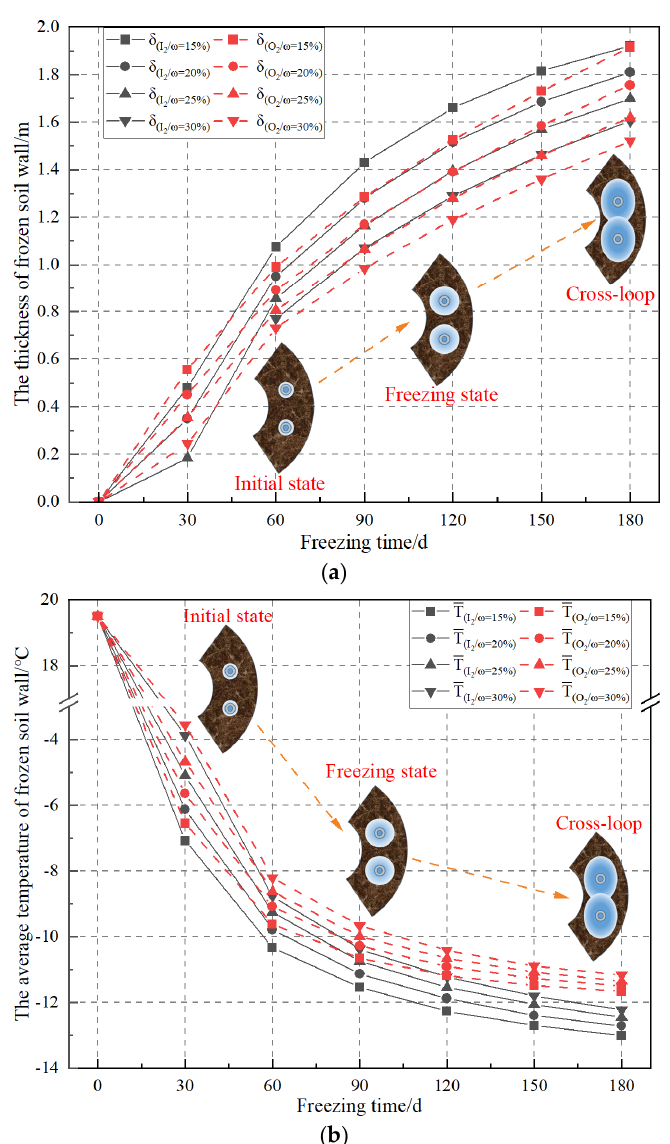
Figure 22. Variance in thickness and temperature of frozen soil wall under different soil moisture contents: ( a ) the effect of soil moisture content on the thickness of frozen soil wall, ( b ) the effect of soil moisture content on the temperature of frozen soil wall.